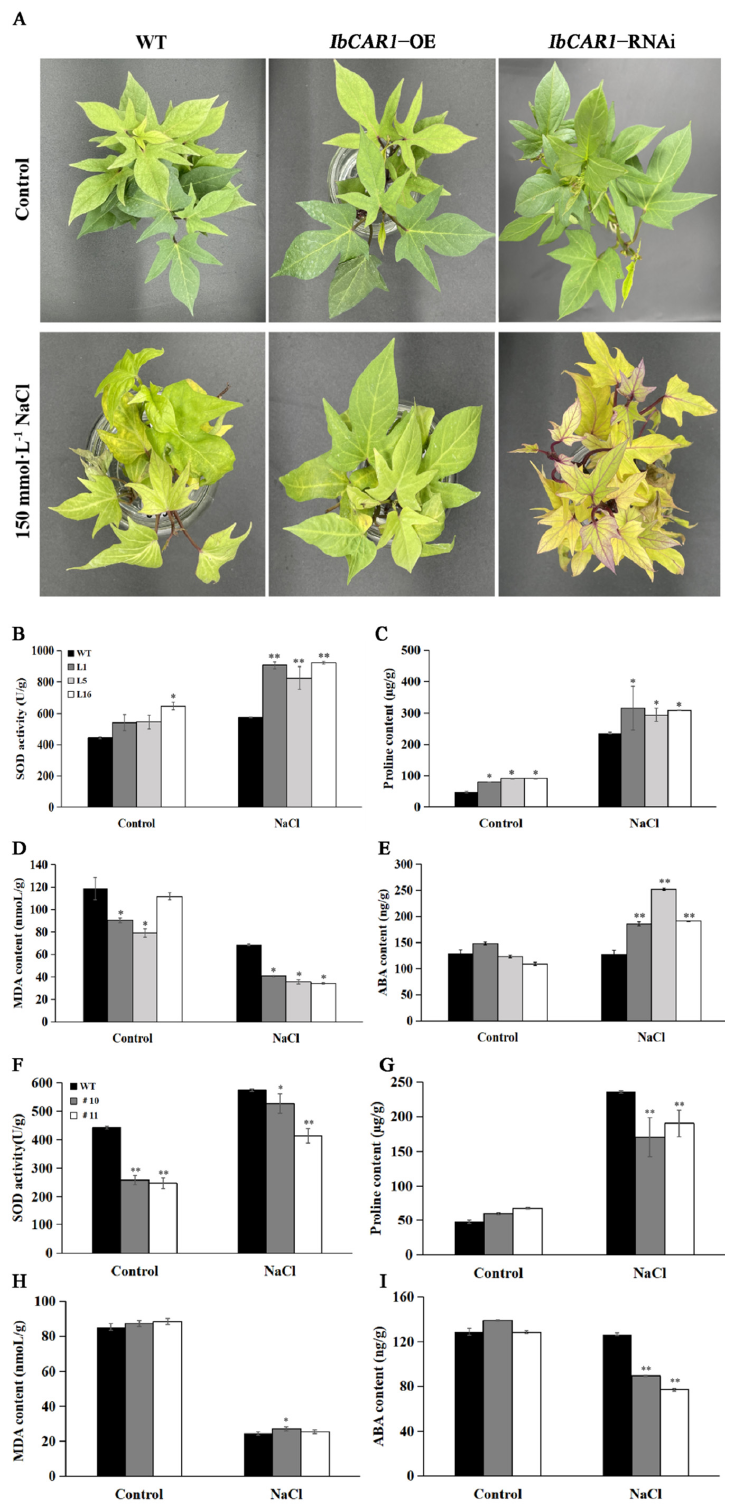
Figure 5. Analysis of the function of sweet potato IbCAR1 under normal and salt stress. ( A ) Pheno- typic analysis of WT and transgenic sweet potato under salt stress. ( B – E ) The SOD ( B ), Proline ( C ), MDA ( D ), and ABA ( E ) contents of WT and overexpressed plant leaves under normal and salt stress. ( F – I ) The SOD ( F ), proline ( G ), MDA ( H ), and ABA ( I ) contents of WT and RNAi plant leaves under normal and salt stress. Data are presented as means ± SE ( n = 3). ** and * indicate significant differences between the transgenic lines and WT at p < 0.01 and p < 0.05 levels,